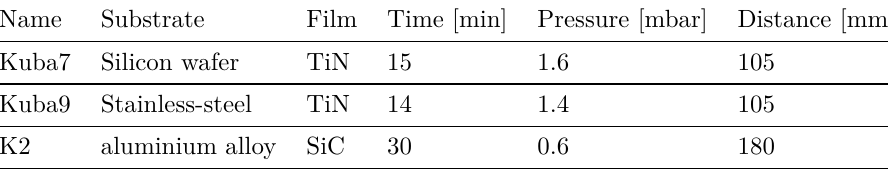
Table 1. Deposition parameters.